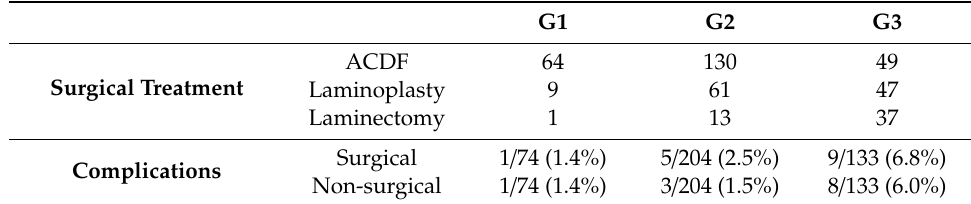
Table 4. Surgical treatment and complications according to the age groups; ACDF: Anterior cervical discectomy and fusion.